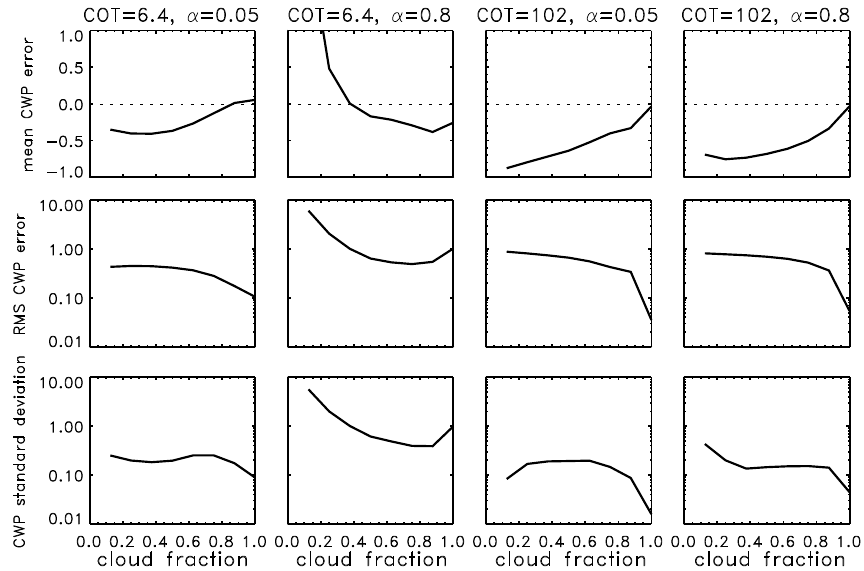
Fig. 8. As Fig. 6, except the errors are shown as functions of the cloud fraction for several combinations of COT and α surf .